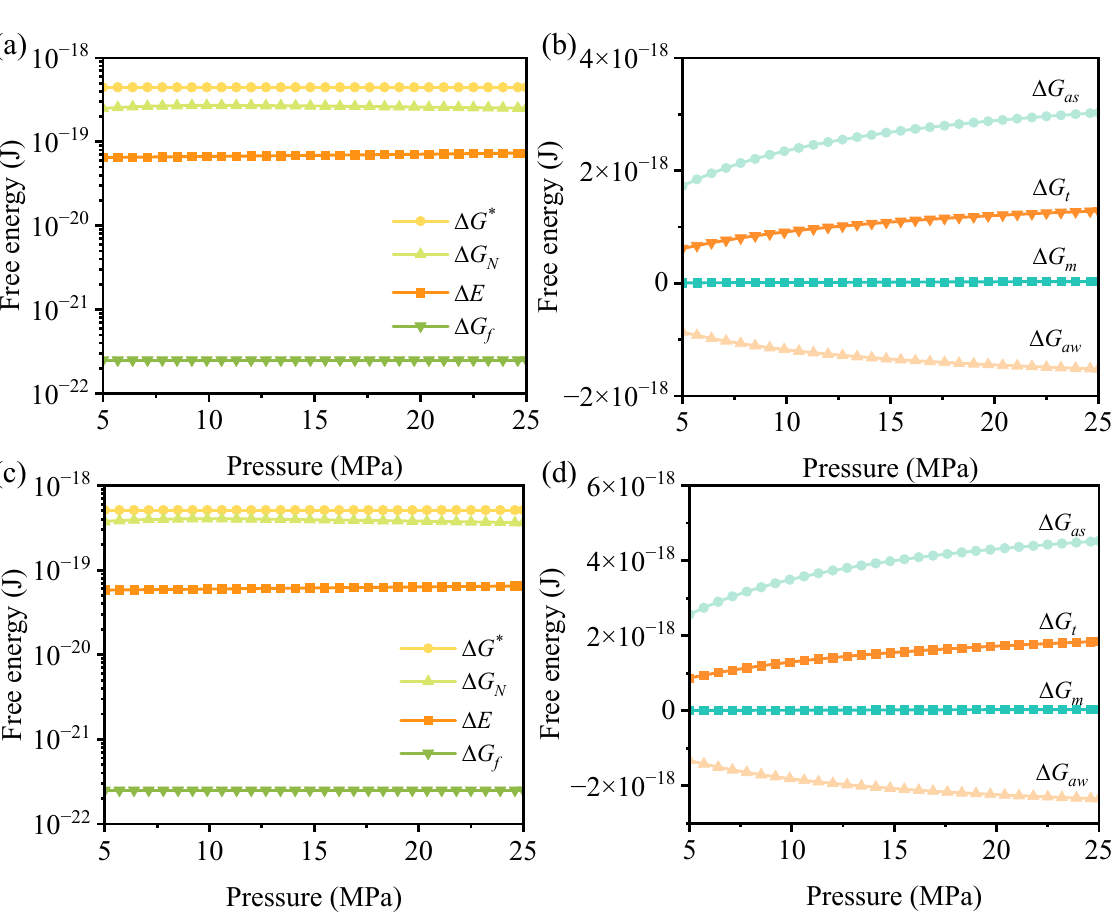
G  accounts for only 19.52% at 6 MPa, t